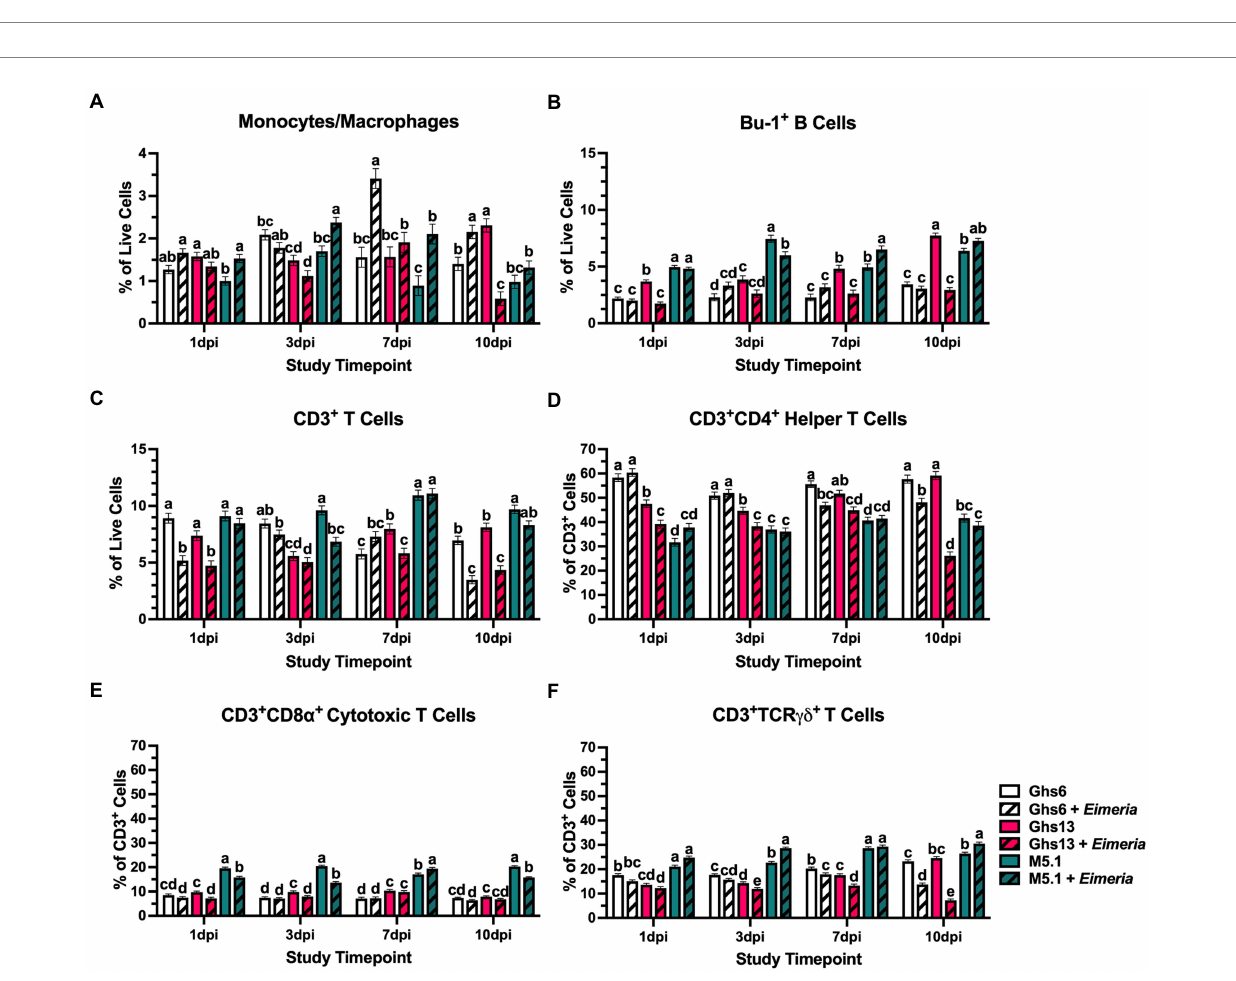
FIGURE 5 Percentages of (A) monocyte/macrophage + , (B) Bu-1 + B cells, (C) CD3 + T cells, (D) CD3 + CD4 + helper T cells, (E) CD3 + CD8 α + cytotoxic T cells, and (F) CD3 + TCR γδ + T cells in peripheral blood mononuclear cells isolated from Leghorn (Ghs6 and Ghs13) and Fayoumi (M5.1) inbred genetic lines at 1, 3, 7, and 10 days post-inoculation (pi) with 10X Coccivac-B52 (Merck Animal Health, Kenilworth, NJ). Data represent the mean percentage of cells positive for each marker among (A–C) live cells or (D–F) CD3 + cells ( n = 5 birds/treatment) ± SEM. Within a post-inoculation timepoint bars with different letter labels are significantly different, p ≤